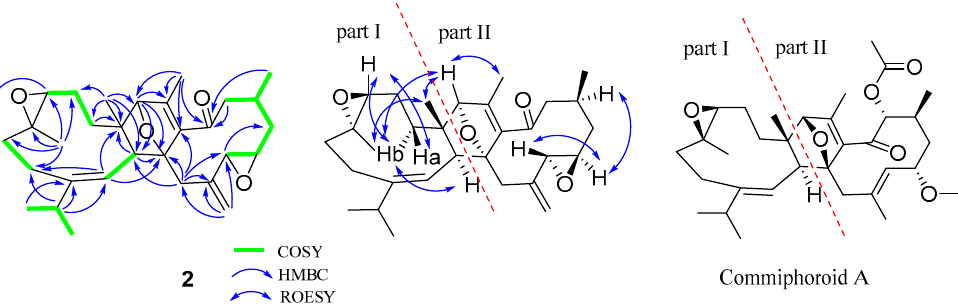
Figure 4. Key 1 H- 1 H COSY and HMBC correlations for 2 and the structure of commiphoroid A.